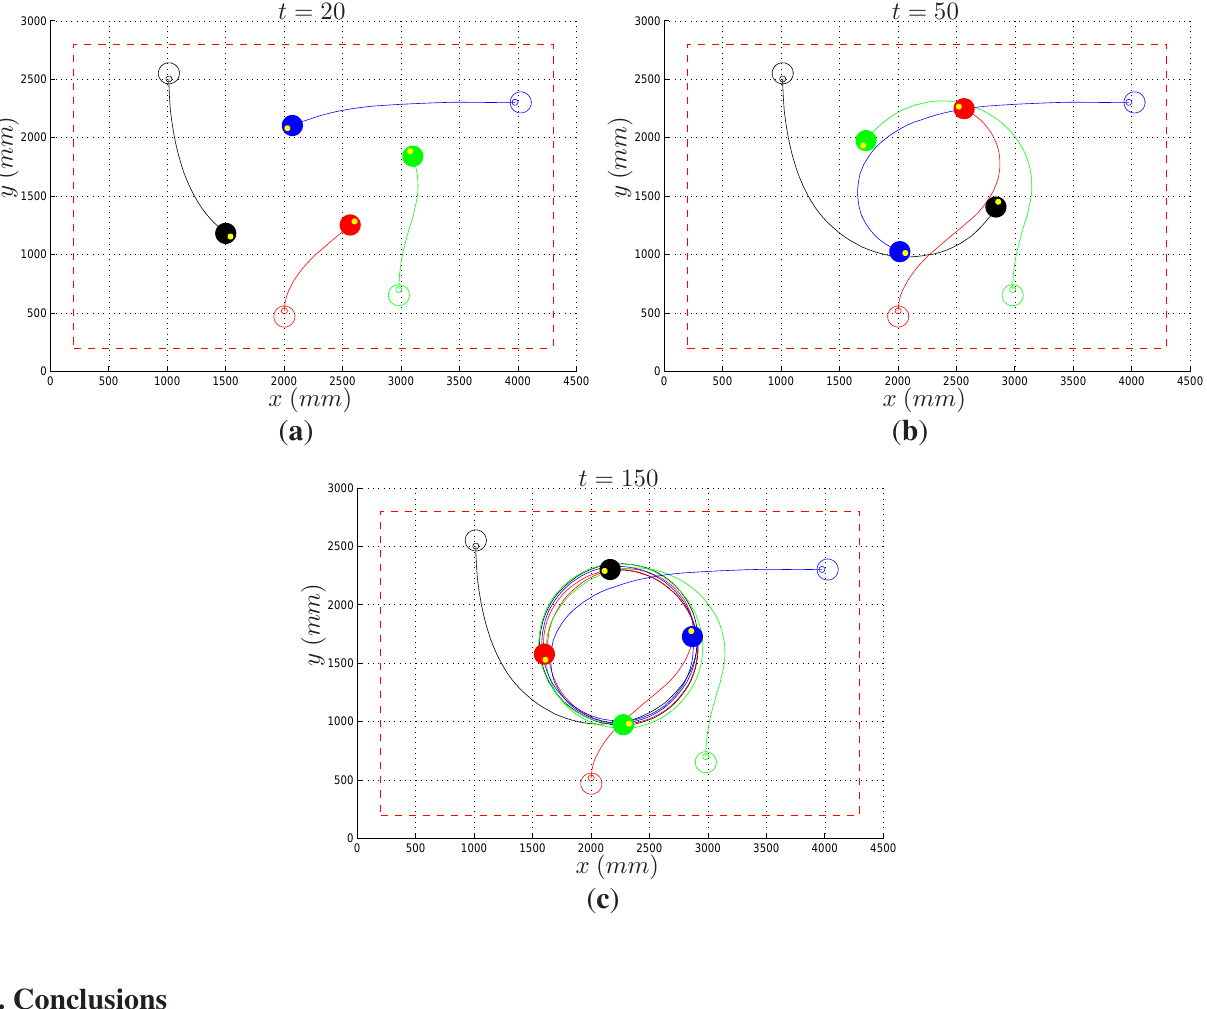
Figure 19. Cyclic pursuit: Three snapshots taken at time t = 20 s ( a ); t = 50 s ( b ); and t = 150 s ( c ). Initial (empty circle) and current (filled circle) robot position; actual robot path (solid